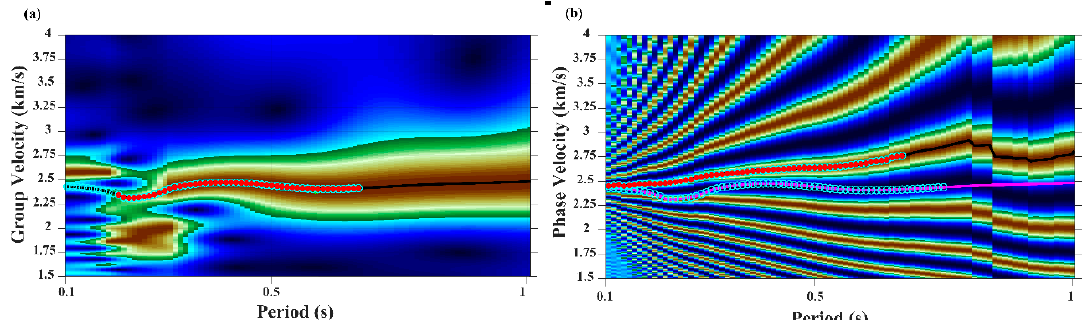
Figure 3. Rayleigh wave group ( a ) and phase ( b ) velocity dispersion curves analysis. Different color shows envelope amplitude at different period and velocity; blue presents lower amplitude and yellow brown show higher amplitude. ( a ) Rayleigh wave group velocity dispersion curves analysis. The horizontal axis is period (s) and the vertical axis is group velocity (km/s). Blue circles are the dispersion points satisfying the threshold of which only red-filled points are saved for inversion. The dark line is the dispersion curve which is predicted by the code. ( b ) Rayleigh wave phase velocity dispersion curves analysis. Horizontal axis is period (s) and vertical axis is group velocity (km/s). Pink line (bottom) shows the group velocity dispersion curves extracted in the previous step, which is used as a reference to guide picking of the corresponding phase velocity dispersion curve.